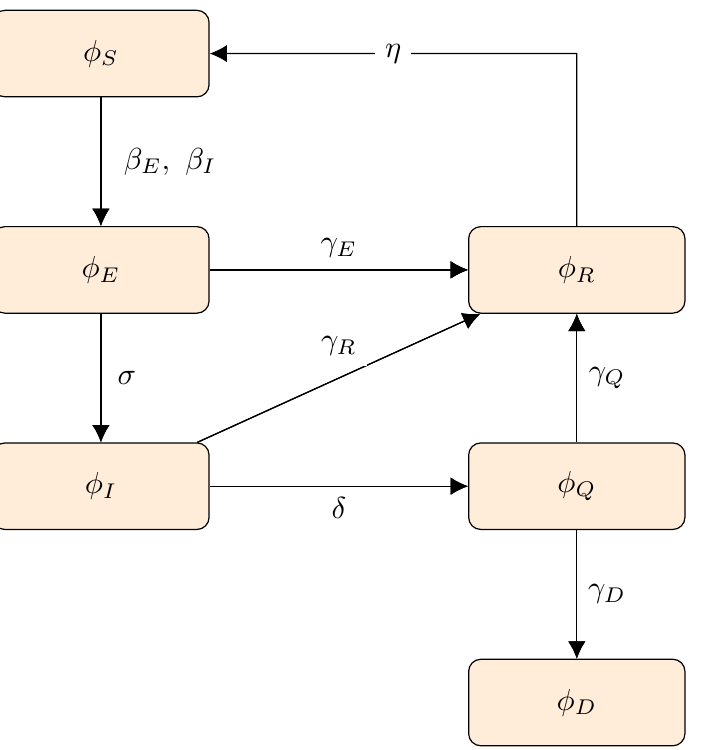
Figure 1. Flow chart depicting the regulating functions γ k , σ , η , β i p k “ E , R , Q , D , i “ E , I q and δ for the respective compartments of the population φ j p j “ S , E , I , R , Q , D q